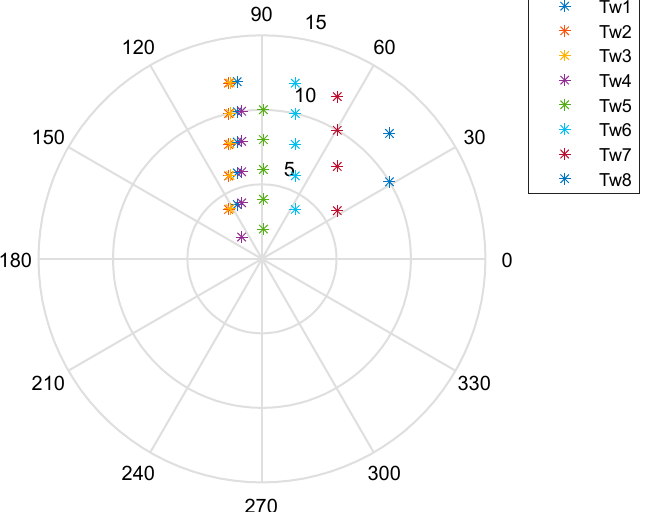
Figure 16. Polar diagram of synchronism representing α angle for different ship speeds.